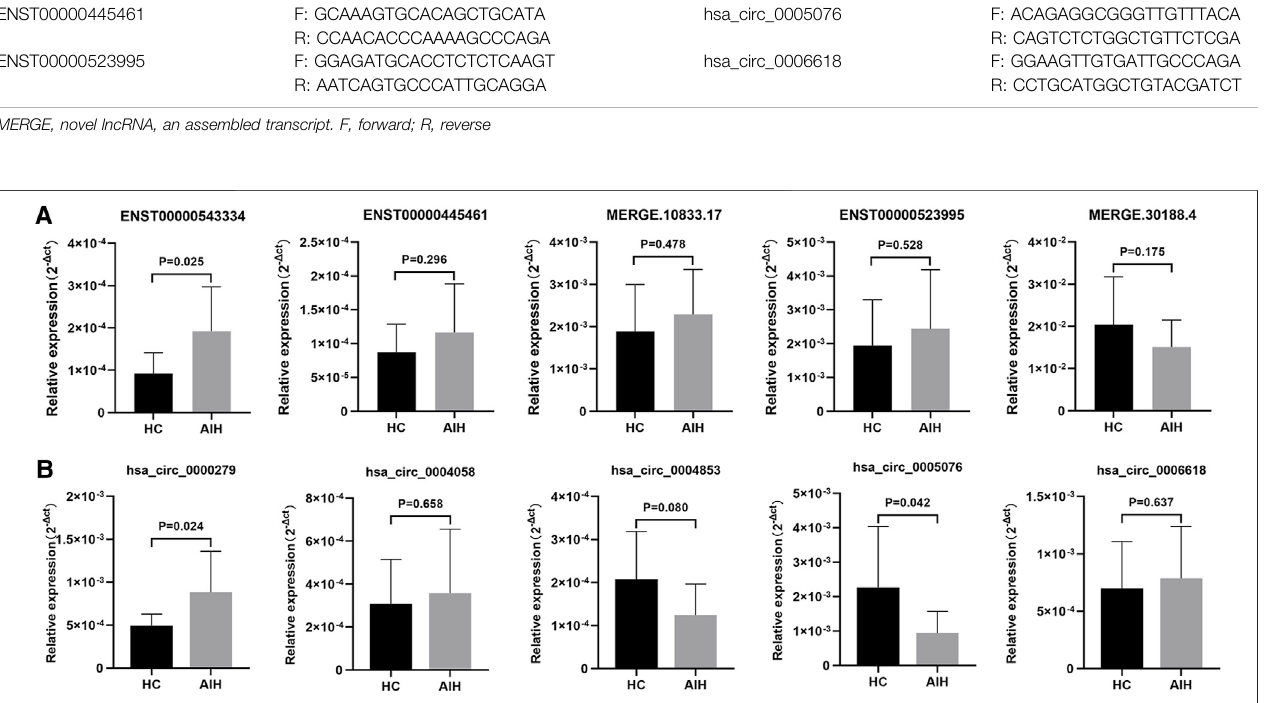
FIGURE 5 | Validation of DE lncRNAs and circRNAs in moDCs from HCs and AIH patients. DE lncRNAs (A) and circRNAs (B) were con fi rmed by qPCR. The expression trends of candidate lncRNAs and circRNAs were consistent with the RNA-seq results. Data are presented as 2 − Δ ct values normalized to ACTIN expression (mean ± standard